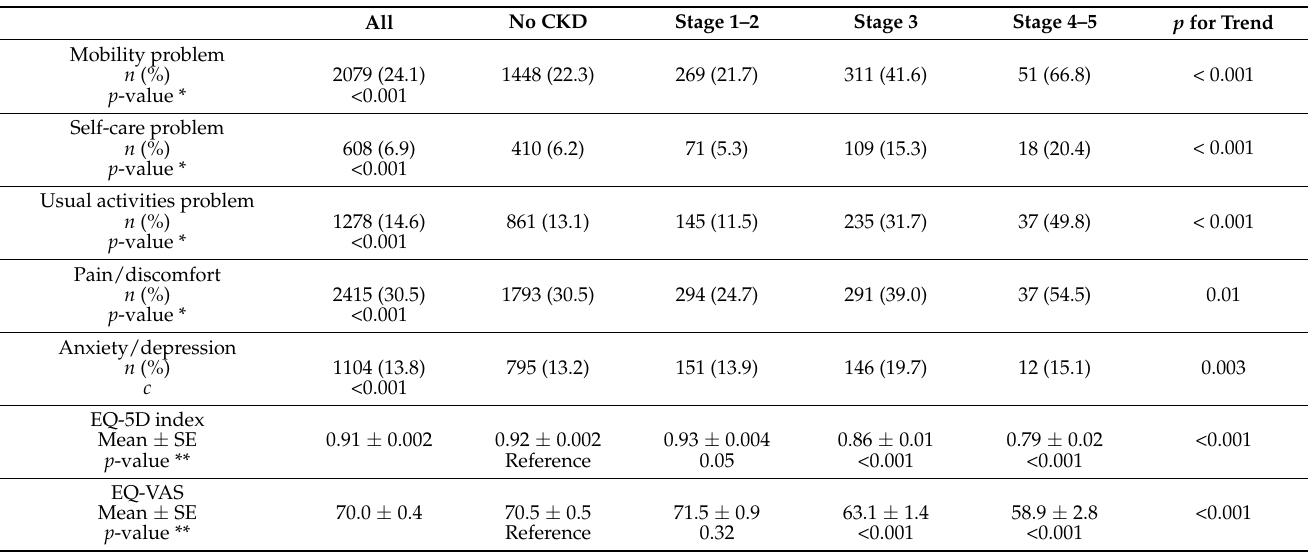
Table 2. Prevalence of having problems in each dimension of EQ-5D, EQ-5D index, and EQ-VAS by stages of chronic kidney disease.